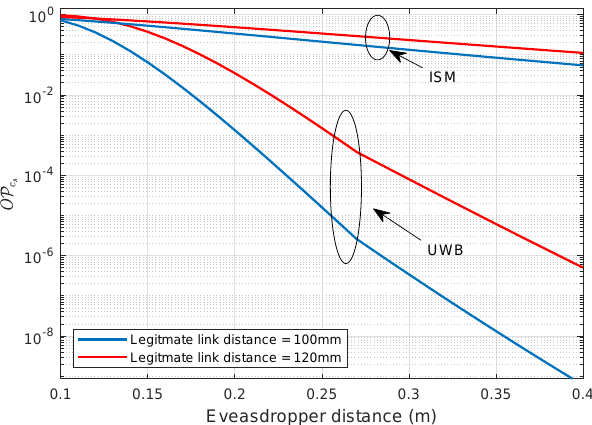
Figure 18. Outage probability of secrecy